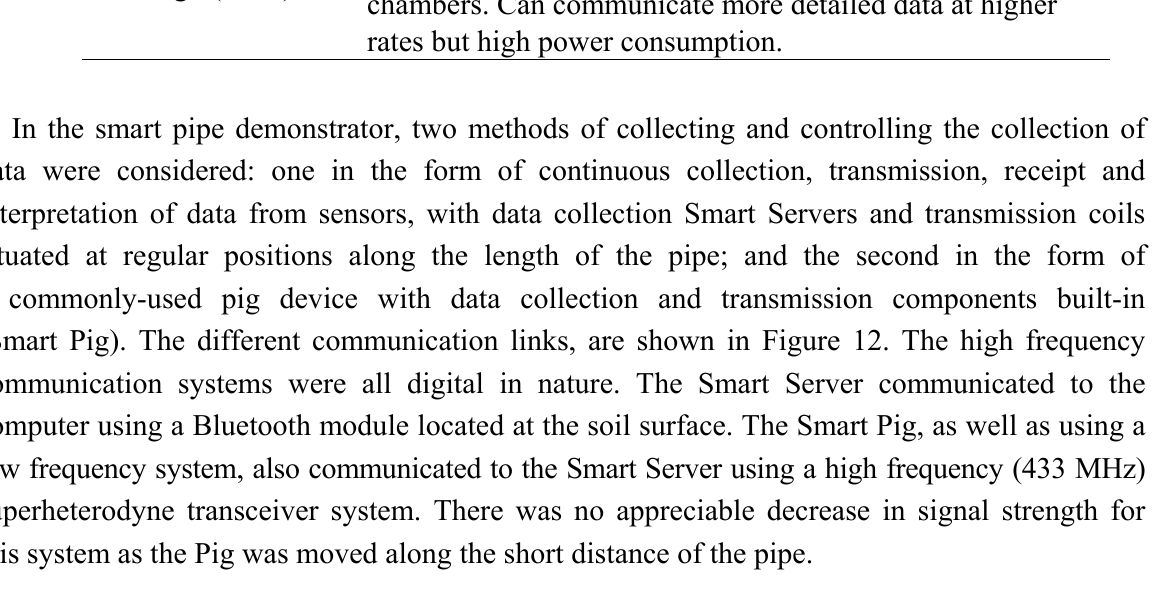
Figure 12. Schematic of the different communication links for the smart pipe